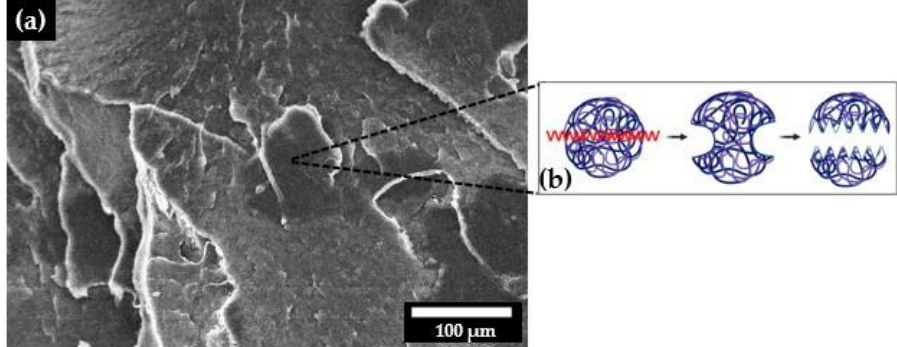
Figure 9. ( a ) SEM micrograph of the fracture surface of the UHMWPE particles and ( b ) mechanism of fracture of these particles, adapted from [36].